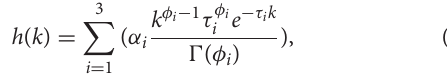
where α 1 is the amplitude, τ i and φ i ( i and scale respectively, and α 2 is the ratio of the peak to the undershoot. If, on the other hand, the initial dip of HbO